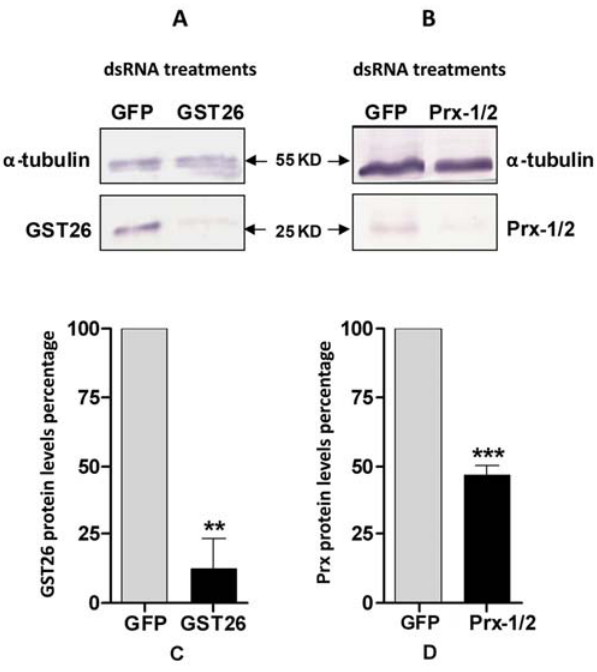
Figure 1. Western blot analyses of SDS-PAGE separated extracts of Schistosomamansoni sporocysts. Larvae were cultured for 7 days in CBSS containing GFP, GST26, or Prx1/2 dsRNA, followed by probing with specific anti-GST26 (Fig. 1A), anti-Prx1 (Fig. 1B) or sample loading control anti- a tubulin antibodies. Using anti- a tubulin reactivity to normalize sample loads, scanning densitometry was used to quantify immunoreactive GST26 (Fig. 1C) and Prx1 (Fig. 1D) intensities in specific dsRNA-treated vs. GFP dsRNA control sporocyst groups. Both GST26 and Prx protein levels were significantly knocked down by 80% and 50%, respectively, when compared to the GFP dsRNA treatment. ** P , 0.01; *** P , 0.001; N=3.